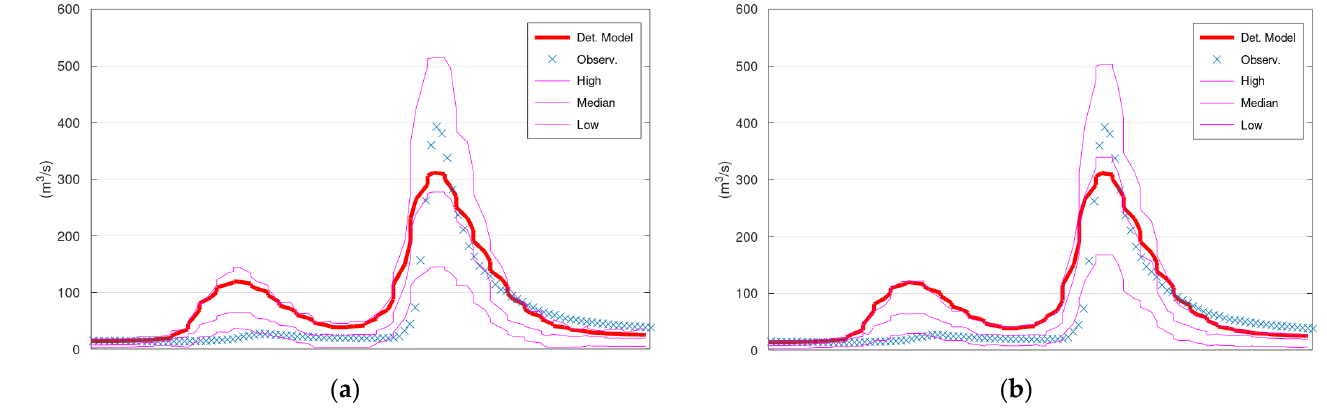
Figure 5. Discharge of Sieve River, 150 hourly time steps of the validation period starting from 5 January 1996: ( a ) KNN; ( b ) Bluecat. “Det. Model” is the simulation with HyMod.